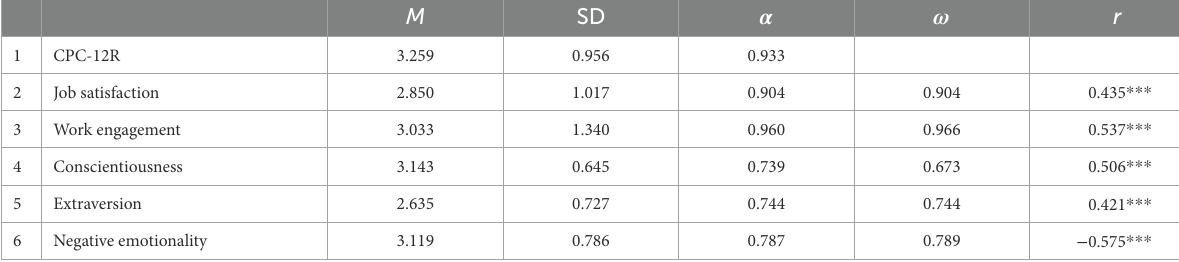
TABLE 4 Correlation of the Compound Psychological Capital Scale (CPC) with related